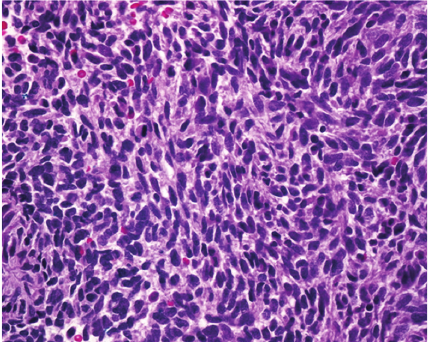
Figure 4: Spindle-shaped cells.